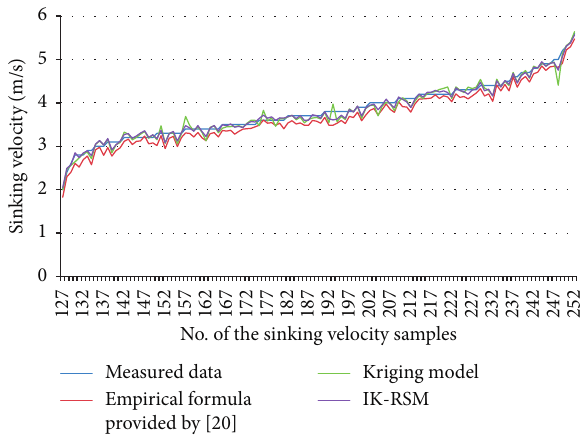
Figure 4: Comparison of the sinking velocity measured data with the prediction results of various models.